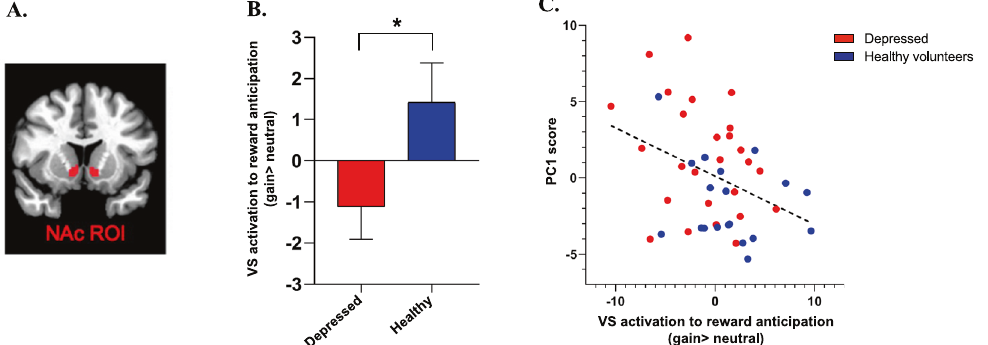
Fig. 3 Blunted response to reward in depression and association with immune reactivity. A Ventral striatum (VS) region of interest (ROI); B Group difference in VS response to reward (gain > neutral cue) during the fi rst run of the task in MDD and HC in VS ROI. C Correlation between immune reactivity, as computed through the principal component 1 (PC1) factor loading, and VS activation to reward (gain cue > neutral cue) on the fi rst run of the (incentive fl anker task) IFT across the